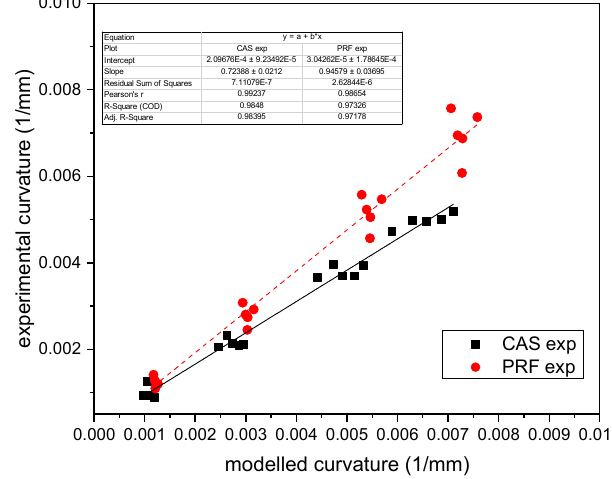
Figure 7. Prediction of multilayer Timoshenko-model with density-dependent strains.